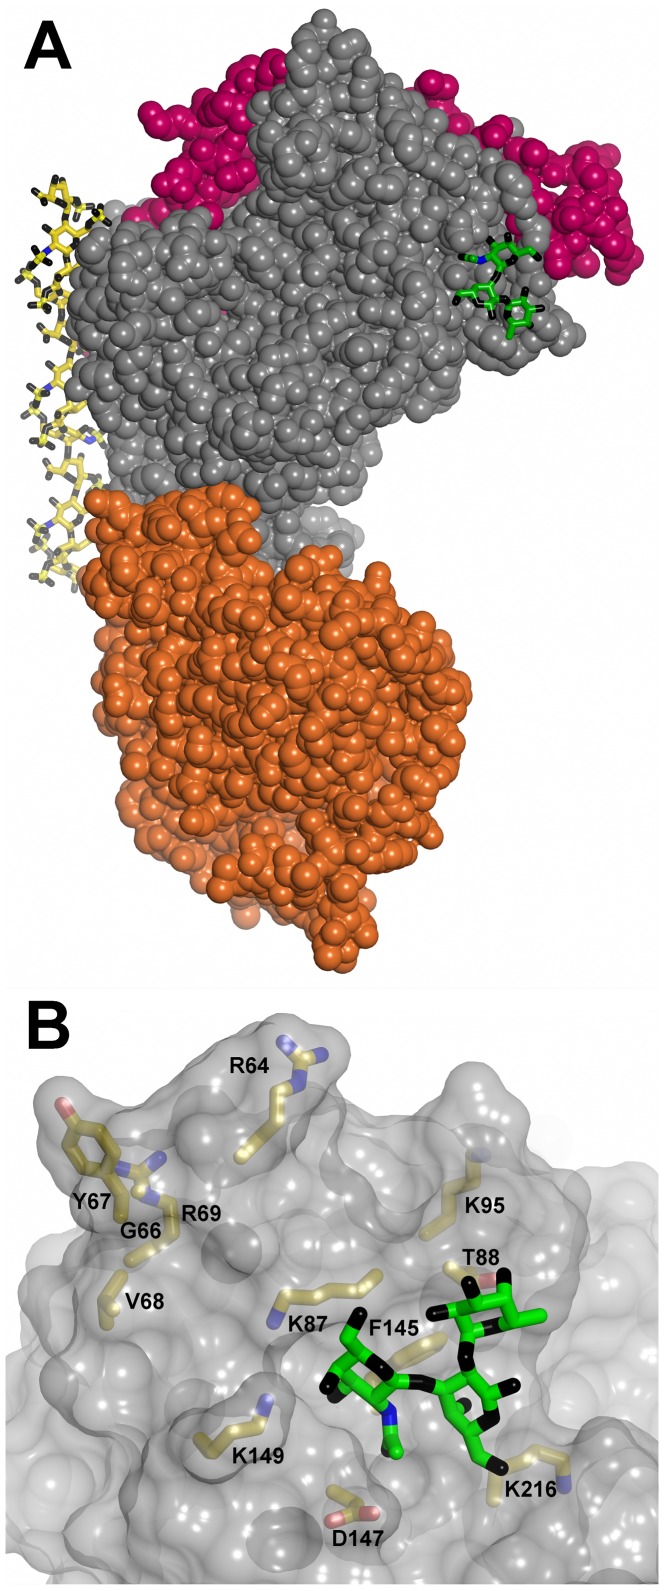
Localisation of the RBC binding site.(A) An overall view of the Head in a space-filling representation (NTS region in mauve, DBL1α1 domain in grey, CIDR1γ domain in orange) with the docked blood group A trisaccharide (green- carbon, black - oxygen and blue - nitrogen) and heparin (carbons in yellow) molecules in stick representation. (B) Detail of the RBC-binding site with side chains whose mutations affect binding highlighted (carbons in yellow, nitrogens in blue and oxygens in red).